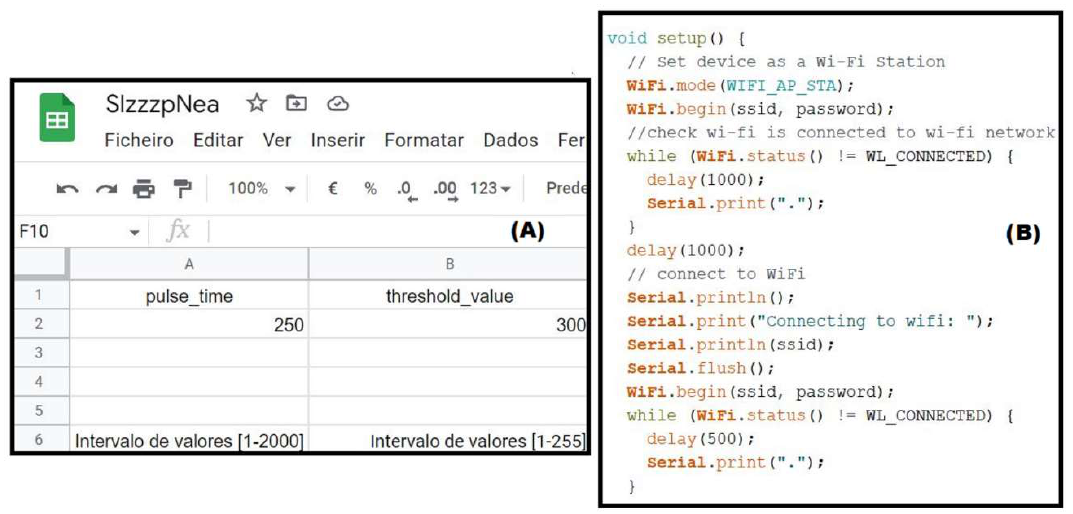
Figure 5. ( A ) Google sheet containing the stimulation parameters and ( B ) code 4 — comms setup.